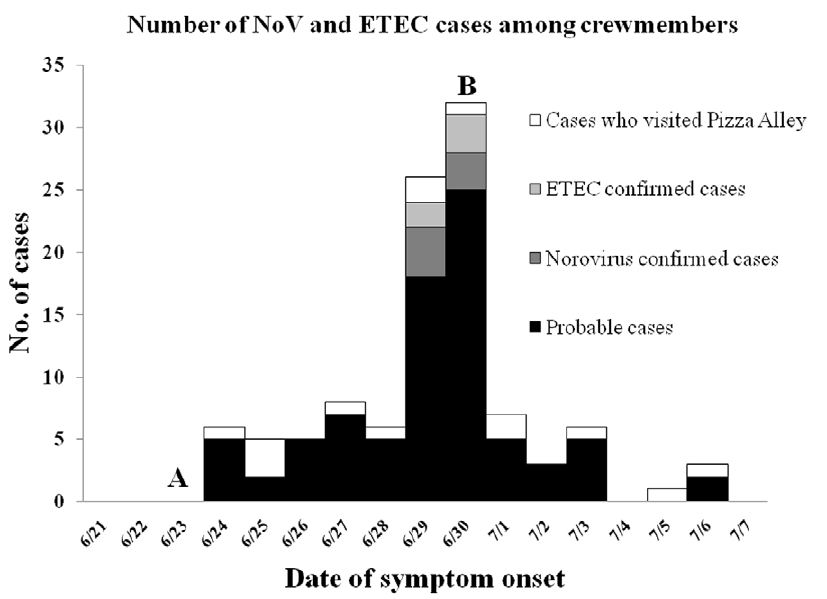
Figure 1. Number of cases of acute gastroenteritis among 230 members of the crew showing the evolution of the outbreak of NoV GI and ETEC in a US Navy ship. A. Crew members visited several locations during their visit to Lima, including ‘‘Pizza Alley’’ a location of many restaurants, bars and nightclubs. B. Control measures included: thorough cleaning of all ship surfaces with a 5% bleach solution, reinforcement of the importance of proper hand washing, provision of hand sanitizers (alcohol hand gel) in each room, recommendation to only consumed cooked foods (including vegetables) and requirement for any crewmember to report to the ships infirmary in the event they develop symptoms of gastroenteritis.